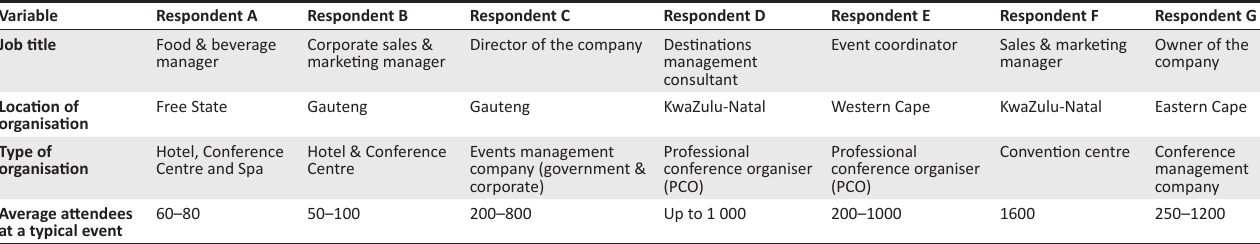
TABLE 1: Demographic profiles of respondents and their organisations.